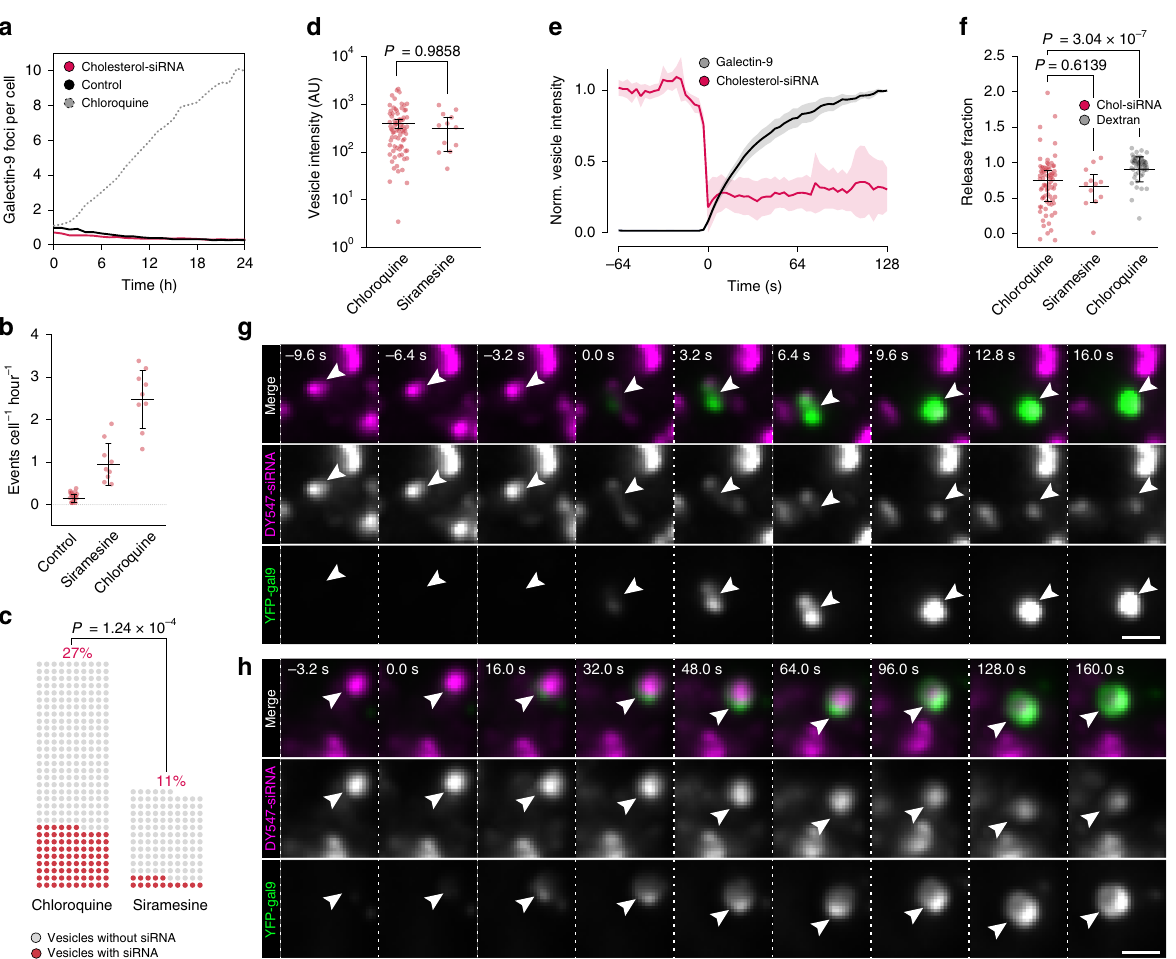
Fig. 5 Endosomal release of chol-siRNA is facilitated by small molecules. a The number of galectin-9 foci per cell was monitored using confocal microscopy during 24 h incubation with 200 nM chol-siRNA. At least 359 control and 737 siRNA-treated cells were analyzed per time point, from two independent experiments. Lines are mean of two experiments. Dotted line is 40 μ M chloroquine for reference. b – h HeLa cells expressing YFP –